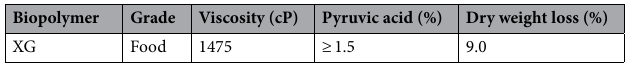
Table 2. Xanthan gum (XG) parameters.